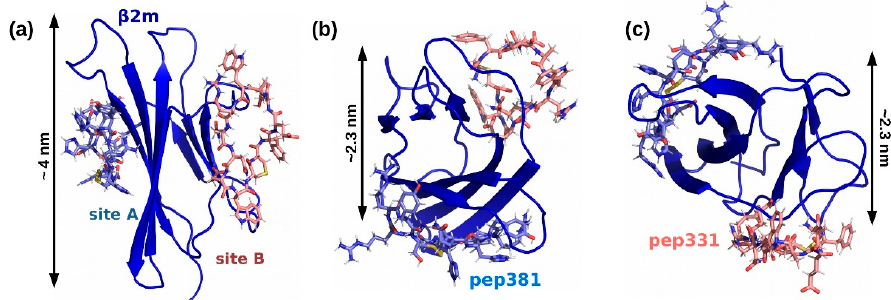
Table 1. Selected peptides sequences and their surface plasmon resonance (SPR)-determined binding affinity ( K D ). ID